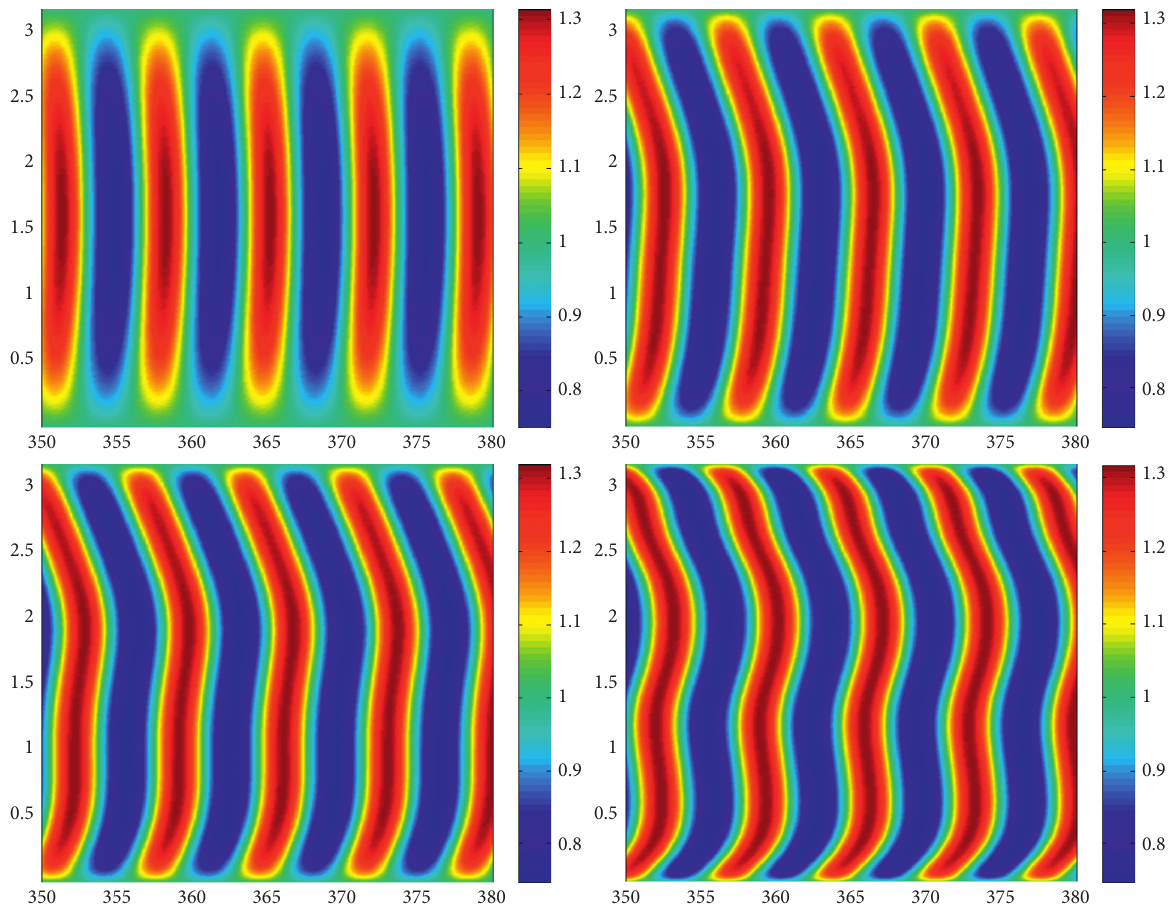
Figure 12: The spatial pattern of the system with Dirichlet boundary for y D � 0 . 01 , 0 . 001 , 0 . 0005 , 0 . i